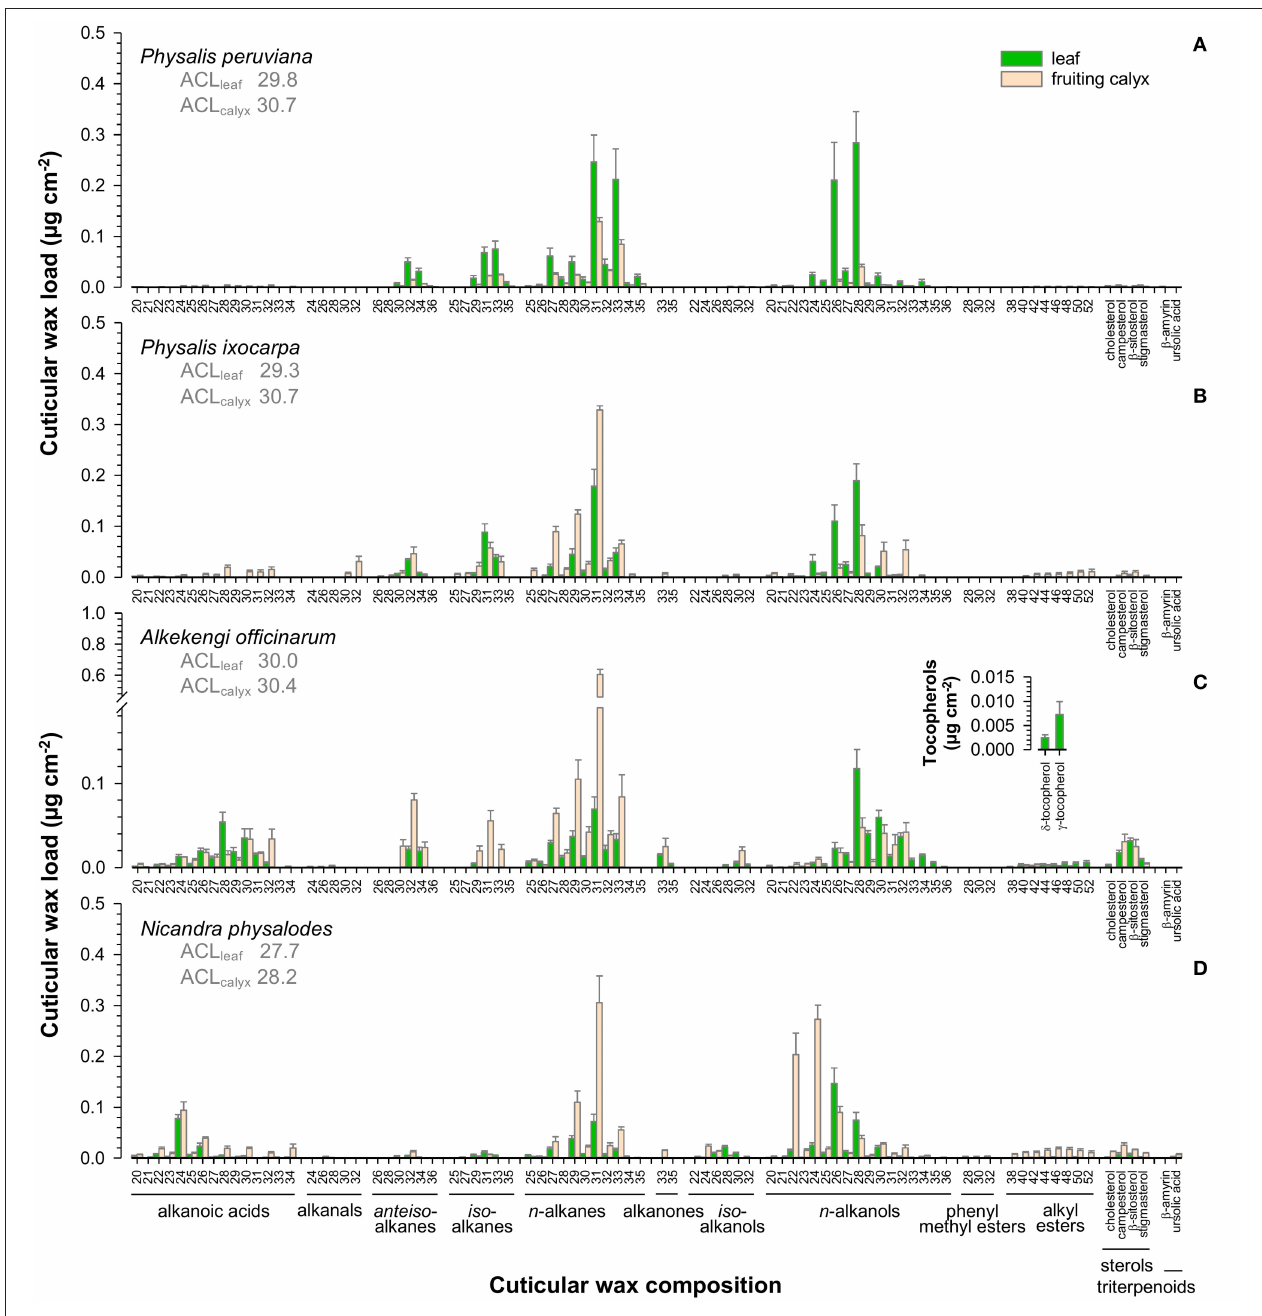
FIGURE 4 | Gas chromatographic analysis of the cuticular wax composition of Physalis ixocarpa (A) , Physalis peruviana (B) , Alkekengi officinarum (C) , and Nicandra physalodes (D) fully expanded leaves and fully inflated fruiting calyces. Average carbon chain lengths calculated for the aliphatic wax fraction are given (ACL). Data are shown as mean ± SD ( n ≥